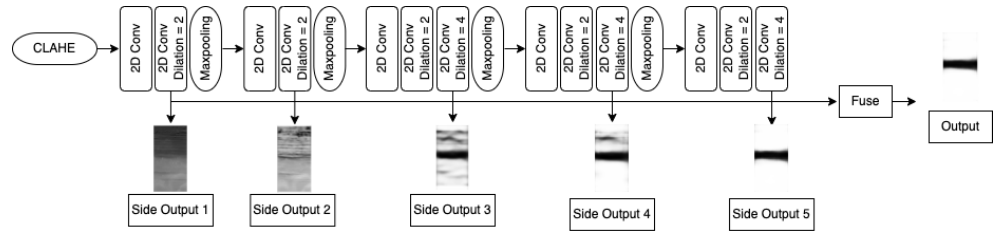
Figure 6. Proposed Architecture.